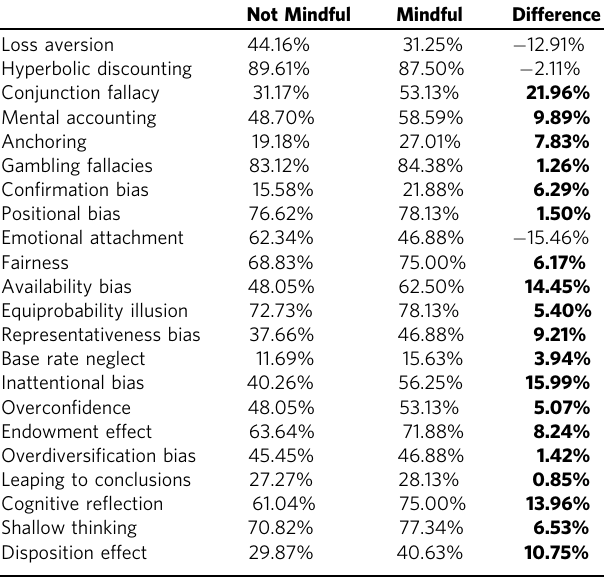
Table 3 Proportion of respondents answering